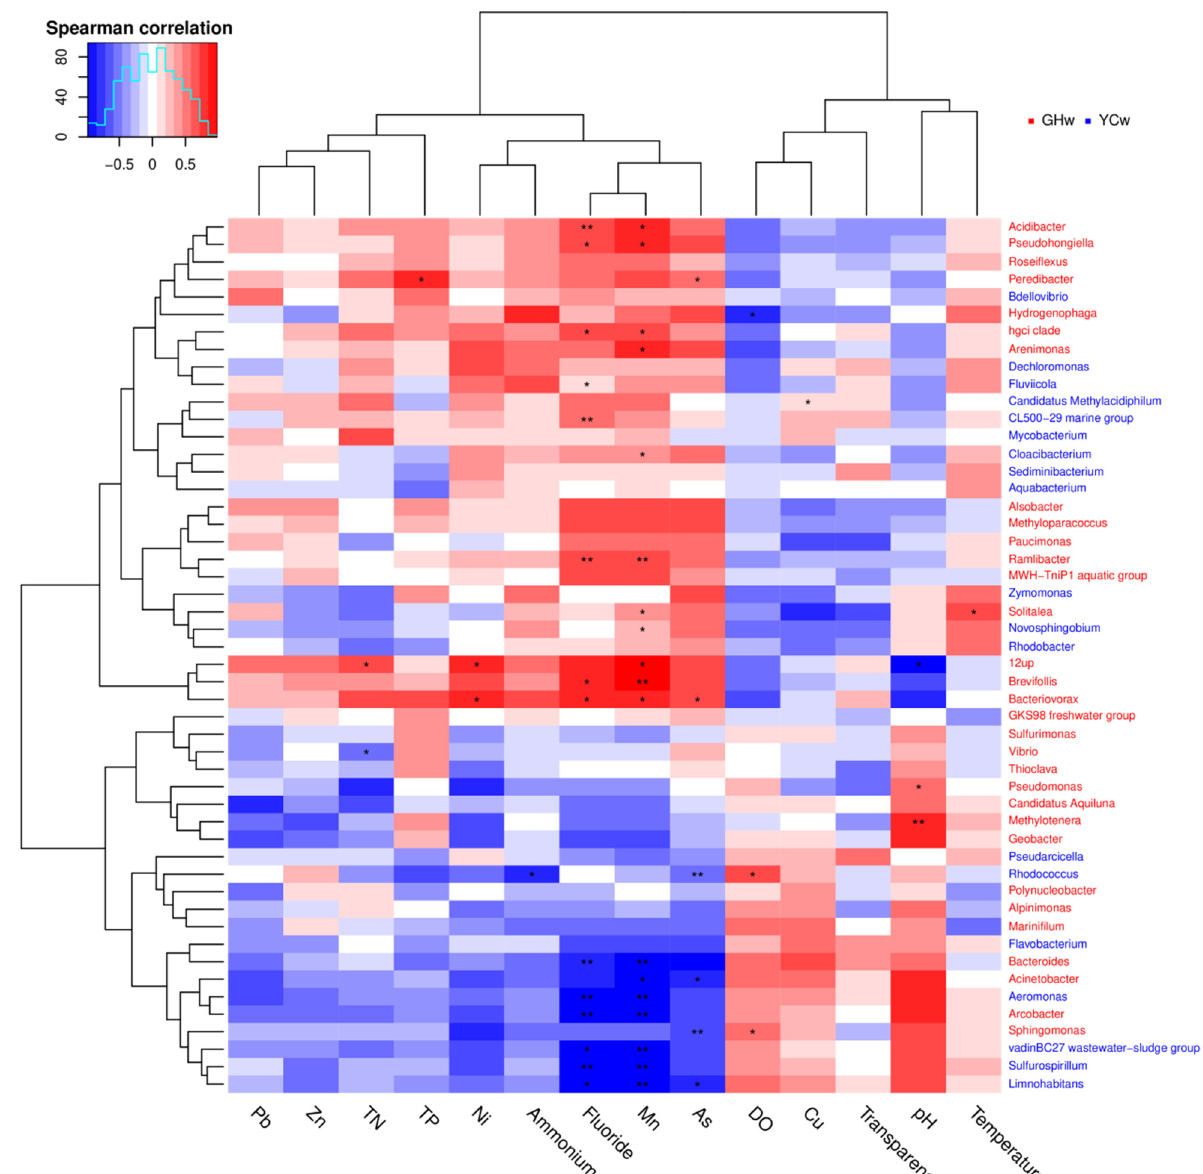
Figure 4. Correlation analysis between the microbial species and environmental factors from all water samples. Each row represents a microbial species and the color of the species name indicates the species that are enriched in the corresponding color group in the upper right corner. The columns represent environmental factors. In the plot, blue-colored boxes represent negative correlations and red-colored boxes represent positive correlations; the darker the color, the stronger the correlation. The * in the figure indicates a p -value < 0.05, and the ** in the figure indicates a p -value < 0.01.